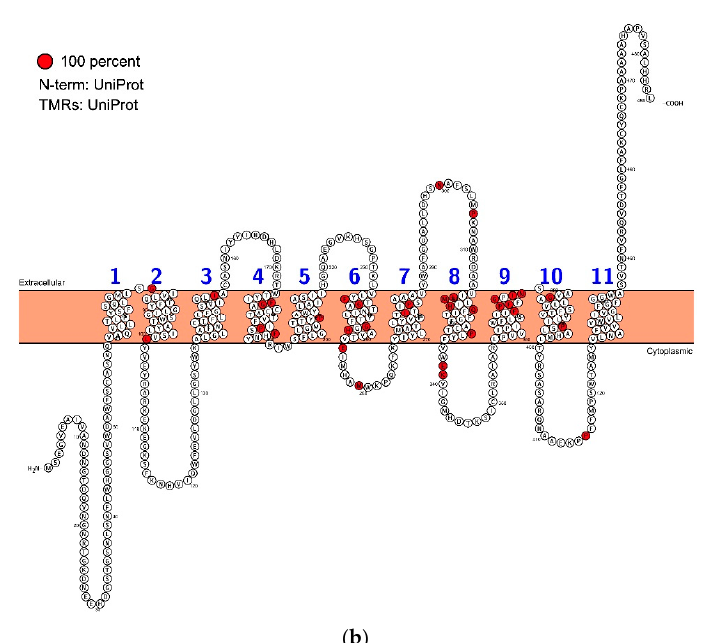
Figure 2. The topology and residue conservation of AUX1. Based on alignment analysis using ClustalW a topological representation of the protein was created using Protter [34]. ( a ) Land plant sequences. Residues coloured red are 100% conserved. The sites of mutations are indicated by circles around relevant residues. ( b ) As for a, but including the sequence data for Chlorella in the analysis. With the identification of the gene for AUX1, heterologous expression in several eukaryotic expression systems allowed a reductionist evaluation of its properties. For example, expression of AtAUX1 in Xenopus oocytes followed by radiotracer accumulation assays gave us kinetic parameters with a Michaelis constant, K M for IAA of 0.84 µM [35]; IAA uptake was shown to be pH-dependent